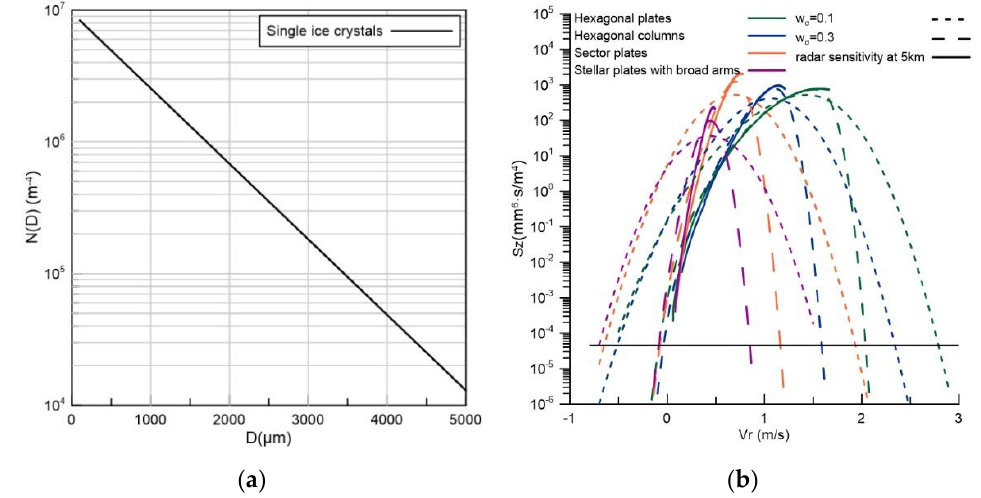
Figure 4. ( a ) Exponential distribution used in this study. ( b ) The Doppler spectral density calculated from the exponential distribution without turbulence (the solid line) and at different turbulence intensities (the dashed line). Radar sensitivity at 5 km of M3 are marked by a solid black line.